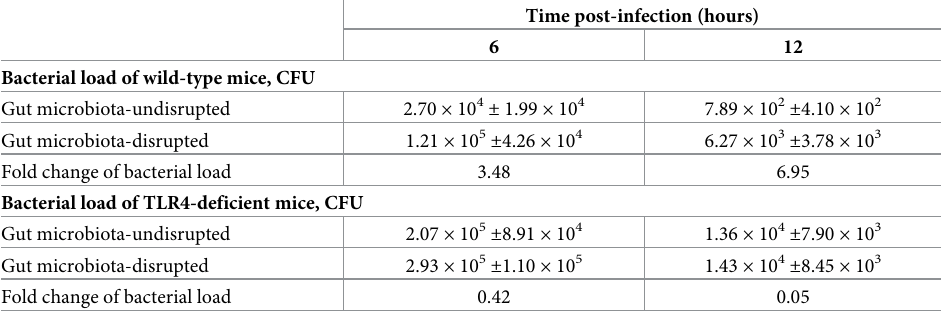
Data are presented as means ± SD (n = 6 per group). Bacterial load of wild-type and TLR4-deficient mice after pneumococcal infection were determined according to Figs 1B and 5B respectively, and the fold change in bacterial load between gut microbiota-disrupted mice and their undisrupted controls was calculated by the following formula: (cid:0) Mean Þ = Mean Fold change of bacterial load ¼ ð Mean disrupted undisrupted undisrupted Mean disrupted , Mean bacterial load of disrupted mice; Mean undisrupted , Mean bacterial load of undisrupted mice; Fold change of bacterial load, fold change of bacterial load between gut microbiota-disrupted mice and their undisrupted controls; CFU, colony-forming